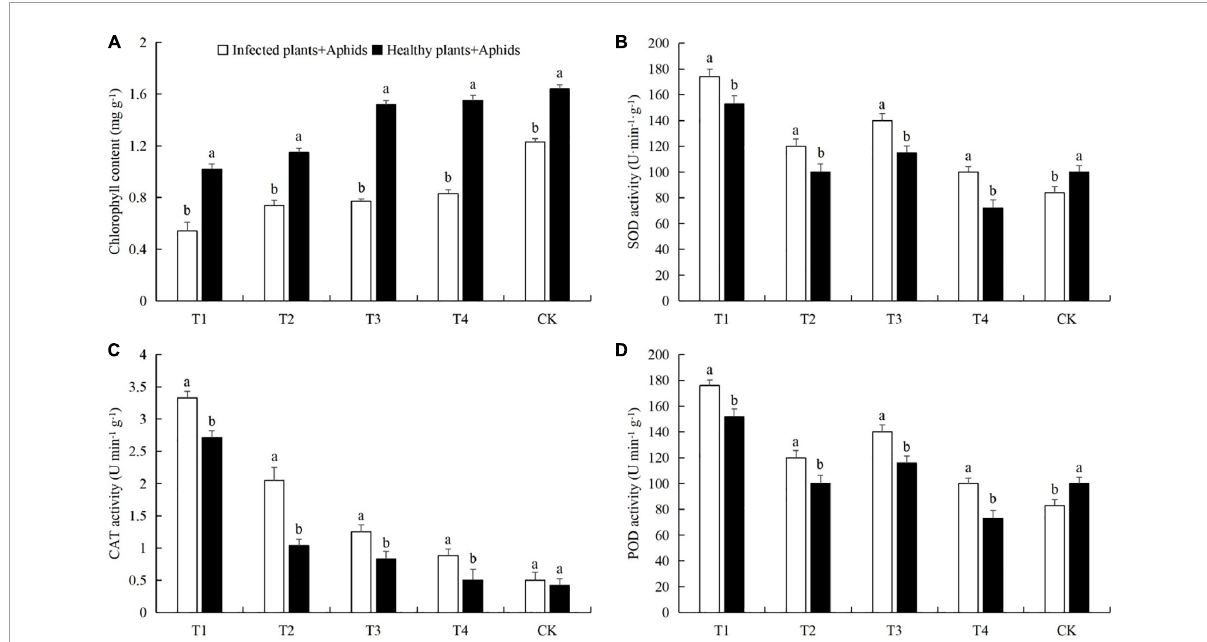
FIGURE5 Effects of different aphid densities on (A) chlorophyll content and the activities of (B) superoxide dismutase (SOD), (C) catalase (CAT), and (D) peroxidase (POD) in cucumber leaves after powdery mildew infection. T1, 160 aphids; T2, 80 aphids; T3, 40 aphids; T4, 20 aphids; CK, 0 aphids. The mean value ± p < 0.05 error bar data were presented in the figure and different alphabetical letters indicate the significant differences between the infected plants + aphids and the healthy plants + aphids.